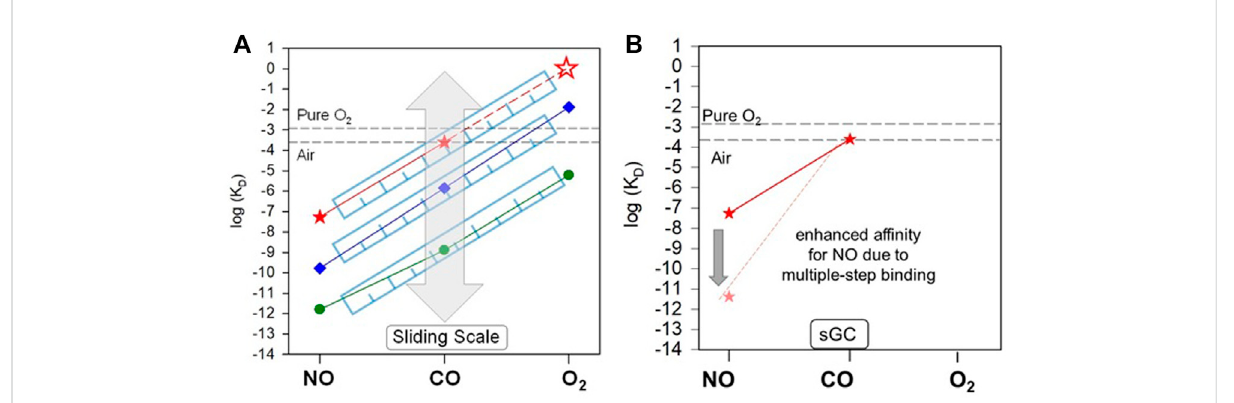
FIGURE 4 “ Slidingscalerule ” andsGCligandselectivity. (A) Theaf fi nitiesofsGCforNO,CO,andO 2 isdeterminedbytheproximalstain ofhemestemmed fromitsstructuralfold. Asrevealedinthe “ sliding scalerule ” ,thestructuralfoldsofhemoproteinsapplyproximalstrainthroughFe-Hisbondstrength and distal hindrance for the gaseous ligand access to heme (the latter is not applicable to sGC), modulating the af fi nities of a hemoprotein for NO, CO, and O 2 simultaneously, but preserving the intrinsic af fi nity ratios of a 5c heme ligated to a neutral histidine ligand. Preservation of the gaseousligandaf fi nityratiosto5chemeandmodulationbyproteinenvironmentsinhemoproteinsareillustratedbytheparallellinesconnectingthe log K D (NO) to log K D (CO) to log K D (O 2 ) of hemoproteins and heme model compounds versus ligand type, as shown here by those of sGC (red), H-NOXproteinfrom Nostoc sp( Ns H-NOX)(blue)andhememodelPP(1-MeIm)(green).The “ sliding ” ofparallellogK D (NO)-logK D (CO)-logK D (O 2 ) lines is represented by the grey block arrow. The K D (O 2 ) of sGC (red empty star) which cannot be determined experimentally is predicted based on the “ sliding scale rule ” by extrapolating the log KD (NO)-log K D (CO) line of sGC (red dashed line). The [O 2 ]in aqueous solutions under 1 atm pure O 2 and air is represented by the black dashed lines. (B) The multiple step NO-binding in sGC, converting the 6c sGC-NO complex to a 5c sGC-NO complex dramatically enhances the af fi nity of sGC for NO, represented by the block arrow indicating the ~4 orders of magnitude decrease from K D (NO) to K D (NO) apparent